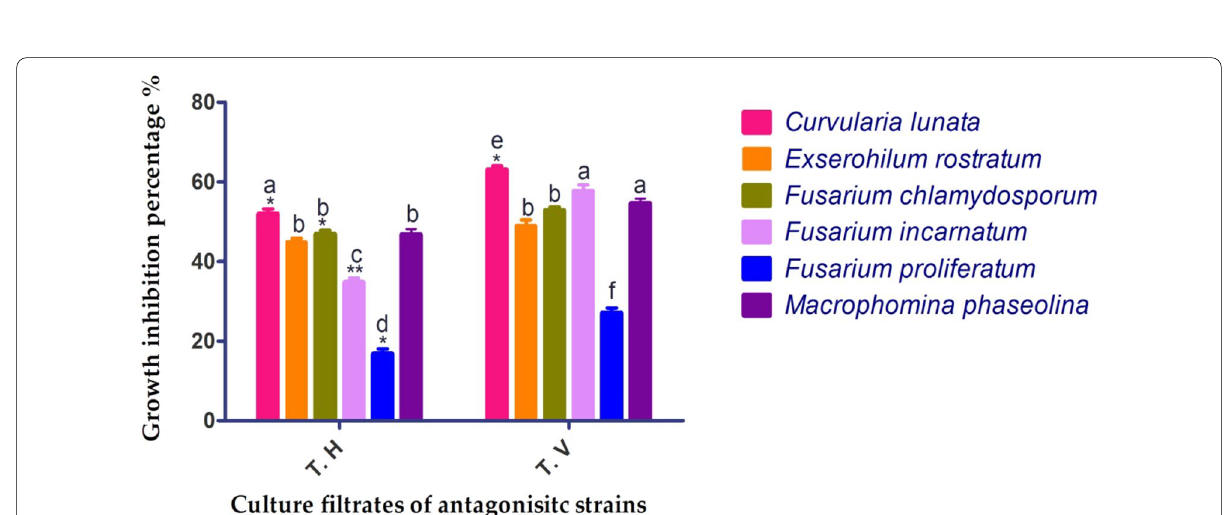
Fig. 3 Anti‑mycotic activity of culture filtrates of T. viride and T. harzianum against different fungal phytopathogens . * Asterisks indicate that the anti‑mycotic activity of the culture filtrate of T. harzianum against Curvularia lunata , Fusarium chlamydosporum , Fusarium incarnatum , and Fusarium proliferatum was significantly different compared with that of T. viride (** P different ( P ≤